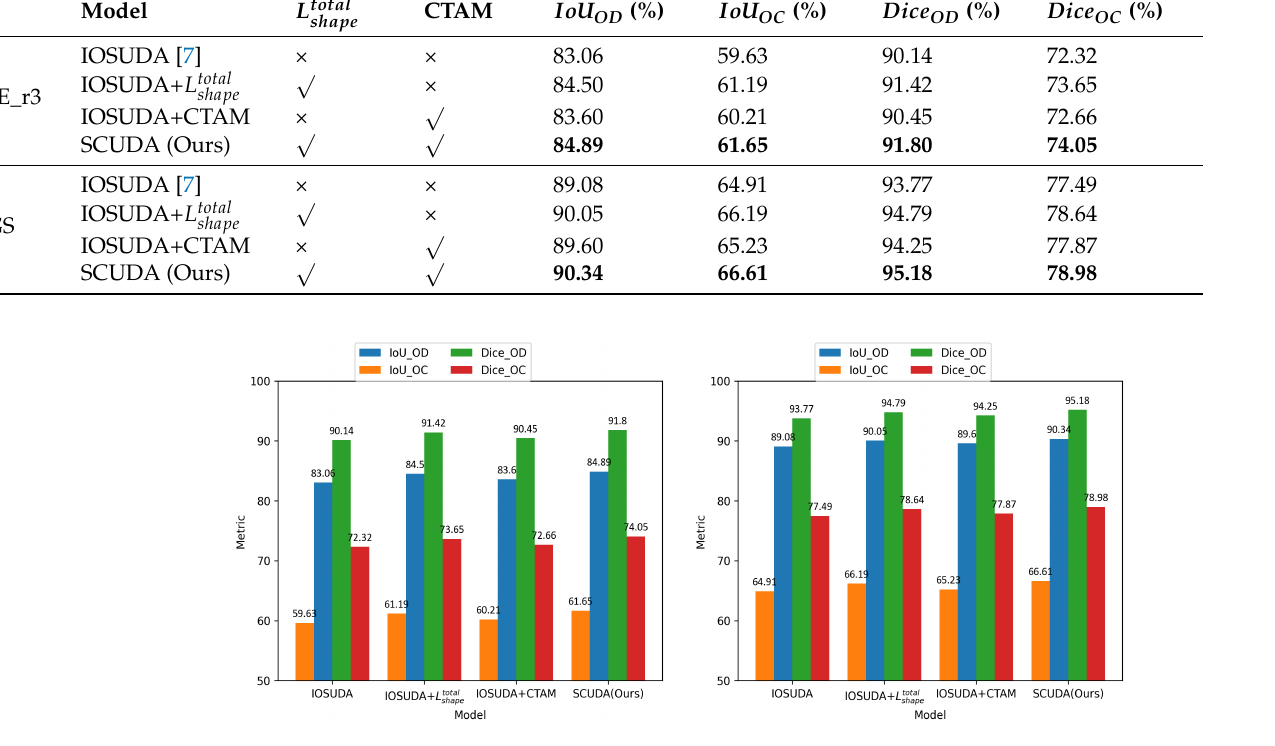
Figure 11. Illustration via bar chart of the effect of the proposed components evaluated on the RIM-ONE_r3 ( left ) and Drishti-GS ( right )